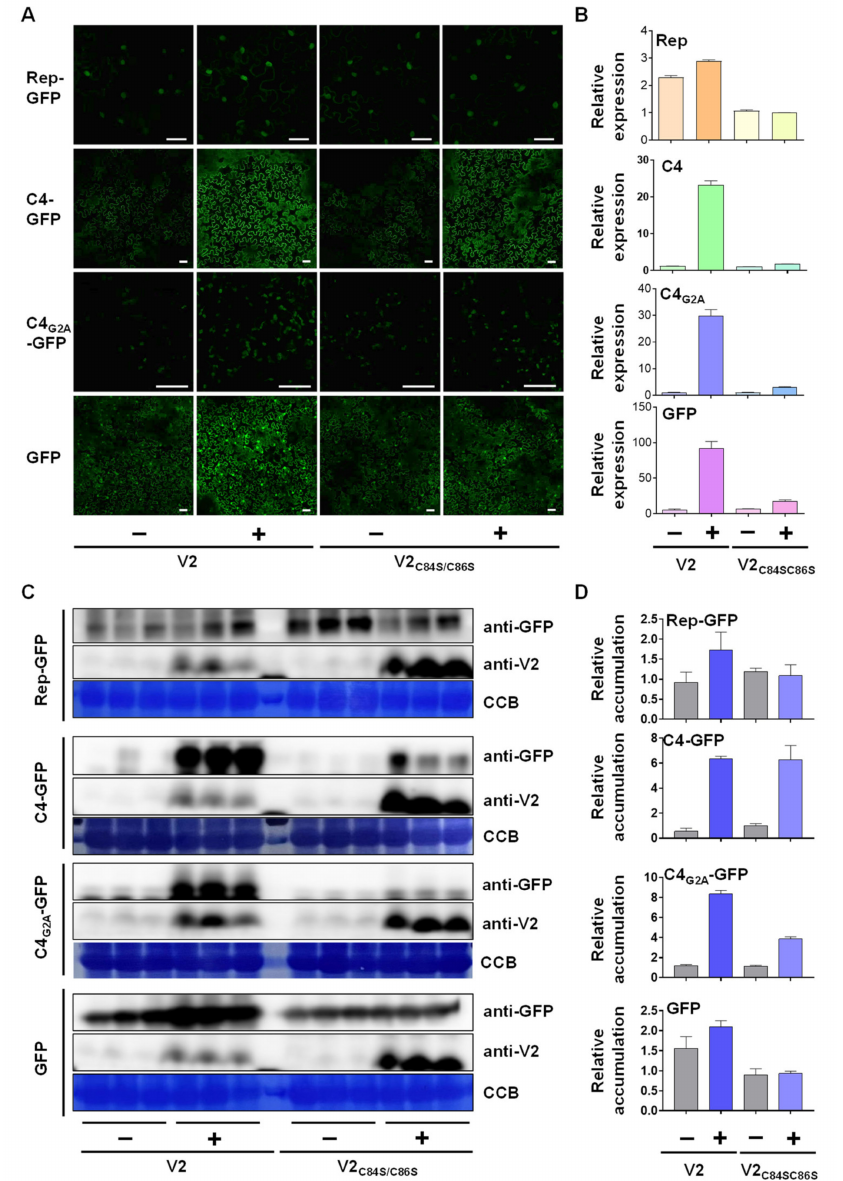
Figure 3. V2 increases the accumulation of the plasma membrane-localized viral protein C4 in- dependently of its silencing suppression activity. N. benthamiana leaves were co-infiltrated with A. tumefaciens carrying constructs to express Rep-GFP, C4-GFP, C4 G2A -GFP, or GFP, and V2 or V2 C84S/C86S , or carrying an empty vector (EV) as negative control. The fluorescence signal was detected under the confocal microscope ( A ), and mRNA accumulation was determined by RT-qPCR at 2 days post-infiltration (dpi) ( B ). Gene expression was normalized to NbEF1a . Values are the mean of three independent biological replicates; error bars indicate SEM. These experiments were repeated three times with similar results; in ( A ), representative images are shown. Scale bar: 50 µ m. Protein accumulation was detected by Western blot ( C ), and the relative abundance of Rep-GFP, C4-GFP, C4 G2A -GFP, or GFP was analyzed by Image J ( D ). Values are the mean of three biological replicates; error bars indicate